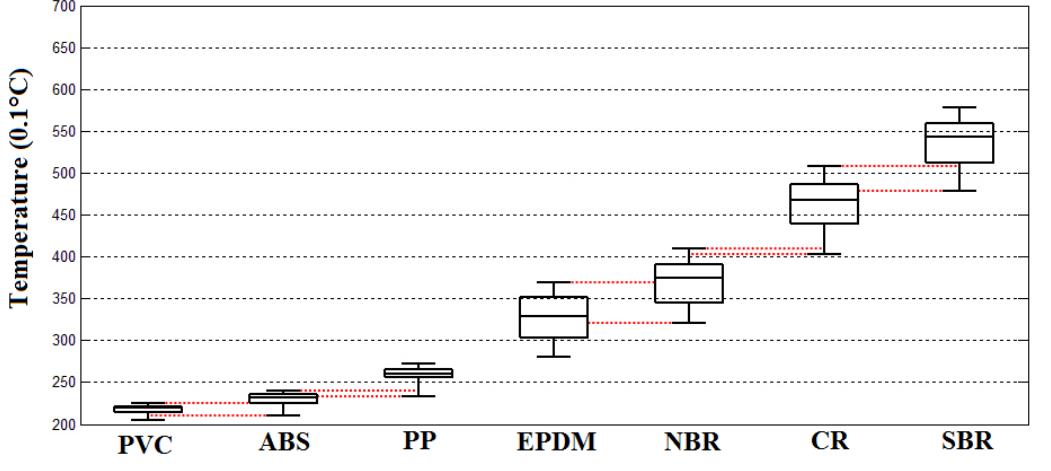
Figure 12. Distribution of temperature rises of the tested polymer samples under a microwave irradiation power of 3 kW.